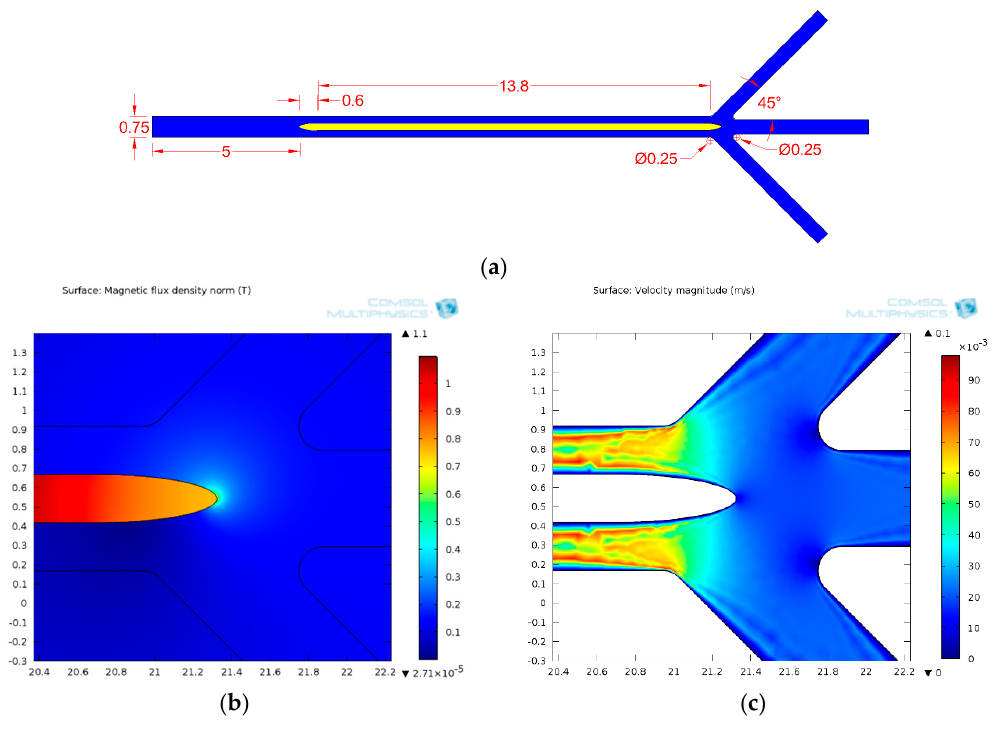
Figure 11. ( a ) Schematic of microfluidic channel layout with rounded corner. The surface plot of the magnetic and velocity field at the optimized ferromagnetic edge region is presented in ( b , c ), respectively.